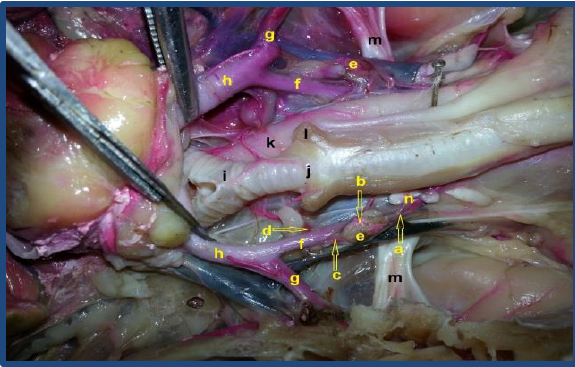
Figure, 3: Photograph showed: a- Cranial thyroid artery b- Middle thyroid artery c-Caudal thyroid artery d- Esophagotracheobranchial artery e-Thyroid gl. f- Common carotid artery g-Subclavian artery h- Brachiocephalic artery i-Syrinx j-Trachea k- Esophagus l-Sternotrachial muscle m- Brachial plexus n- Caudal lobe of